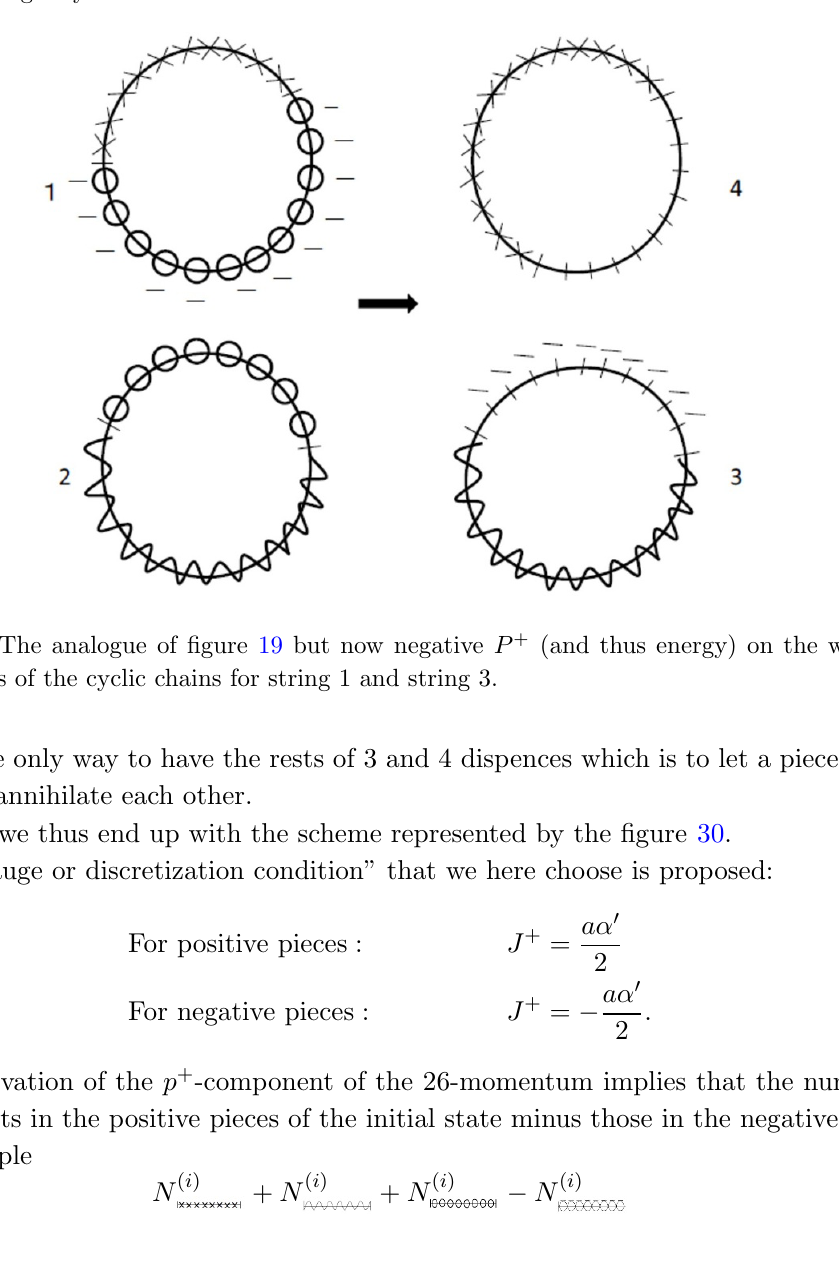
Figure 29 . Incoming string 1 cyclic chain negative part and string 2 cyclic chain splits into the two parts: one annihilates with the negative piece from the cyclic chain 1 and one part of the (cid:12)nal string e.g. string 3 cyclic chain